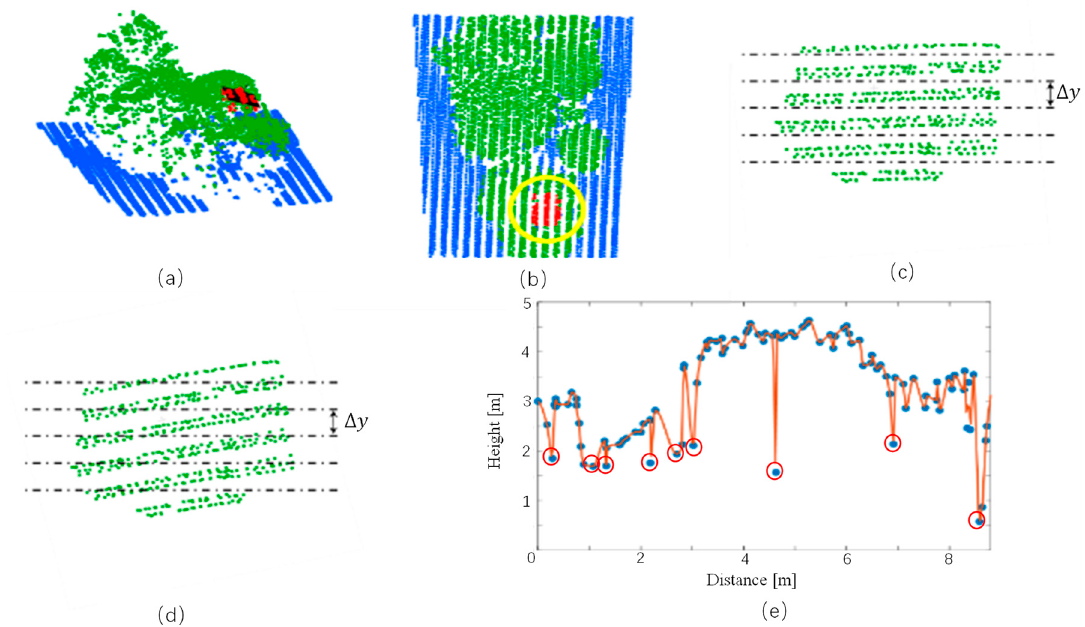
Figure 3. The strategy used in the proposed method to carry out a semantic check. ( a ) Point clouds in 3D space. The green and blue points represent tree and ground, respectively. The red points represent a candidate of semantic segments, e.g., plane segment A. ( b ) Point clouds in 2D space. The yellow circle shows the neighborhood using a cylinder radius. ( c ) Point clouds of A and a designed grid with a fixed step, ∆ y . ( d ) The scanning line is not required to be parallel to the grid. ( e ) Points in one of the grid lines are reordered in a designed 2D system and extreme points (e.g., points in the red circles) can be detected from the 2D curve.